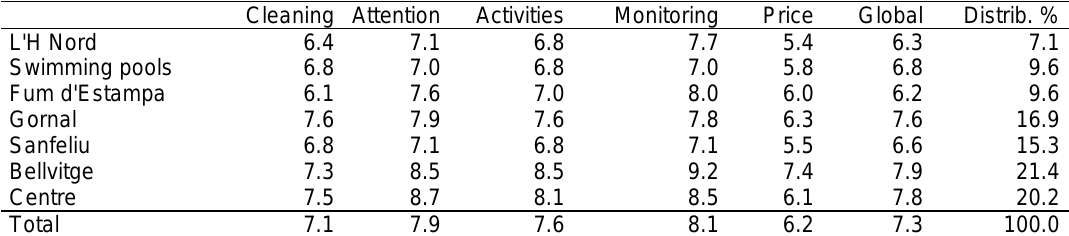
Table 6. Assessment of sports facilities (2017). General